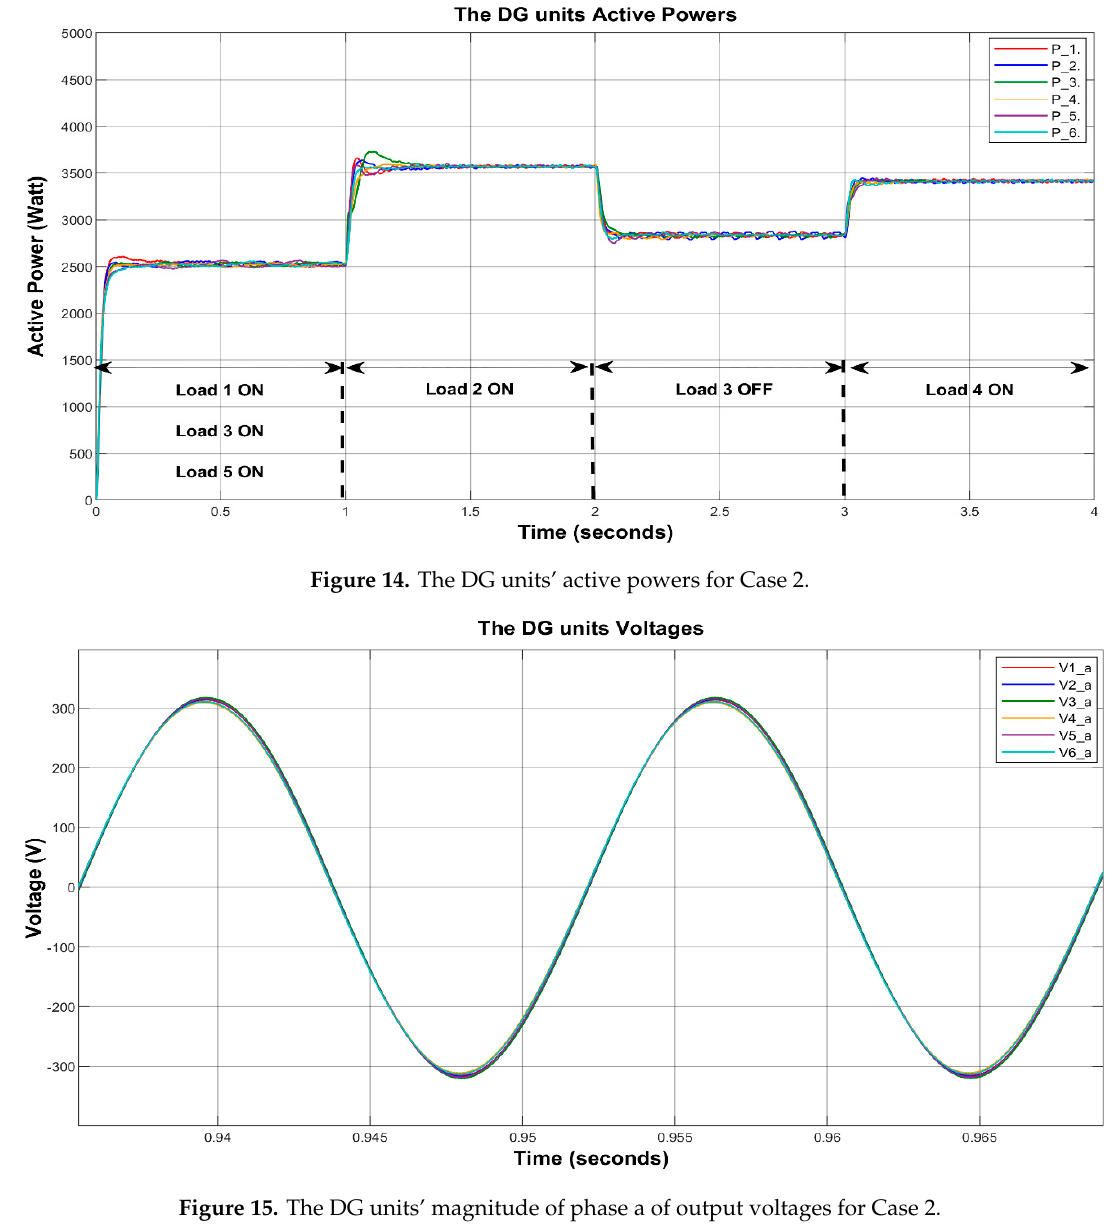
Figure 15. The DG units’ magnitude of phase a of output voltages for Case 2.